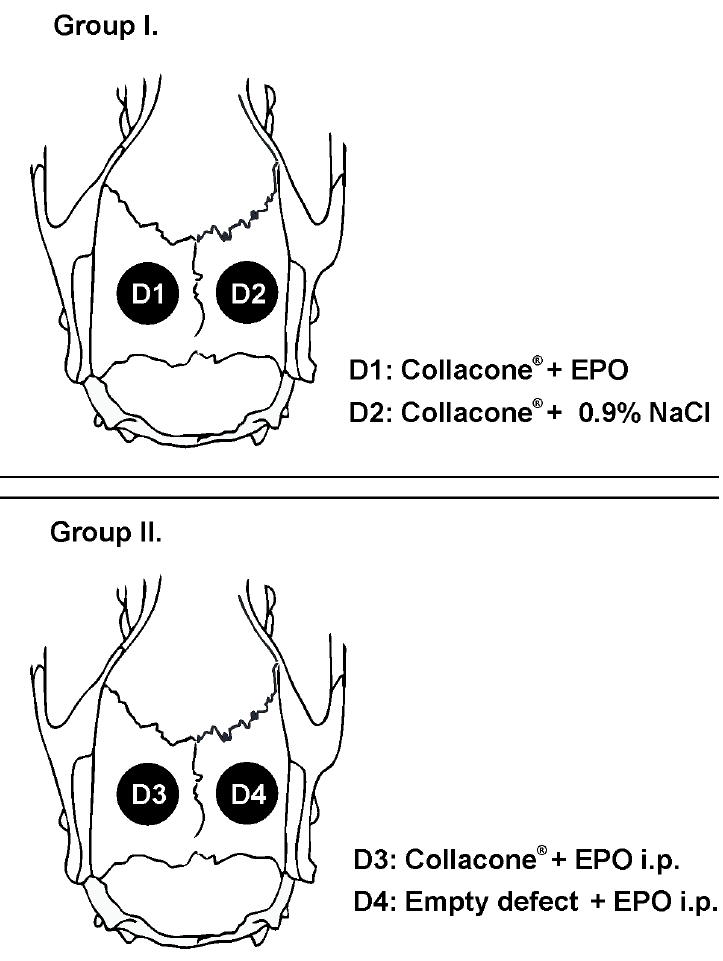
Figure 1. Experimental design—schematic presentation of groups and defects.